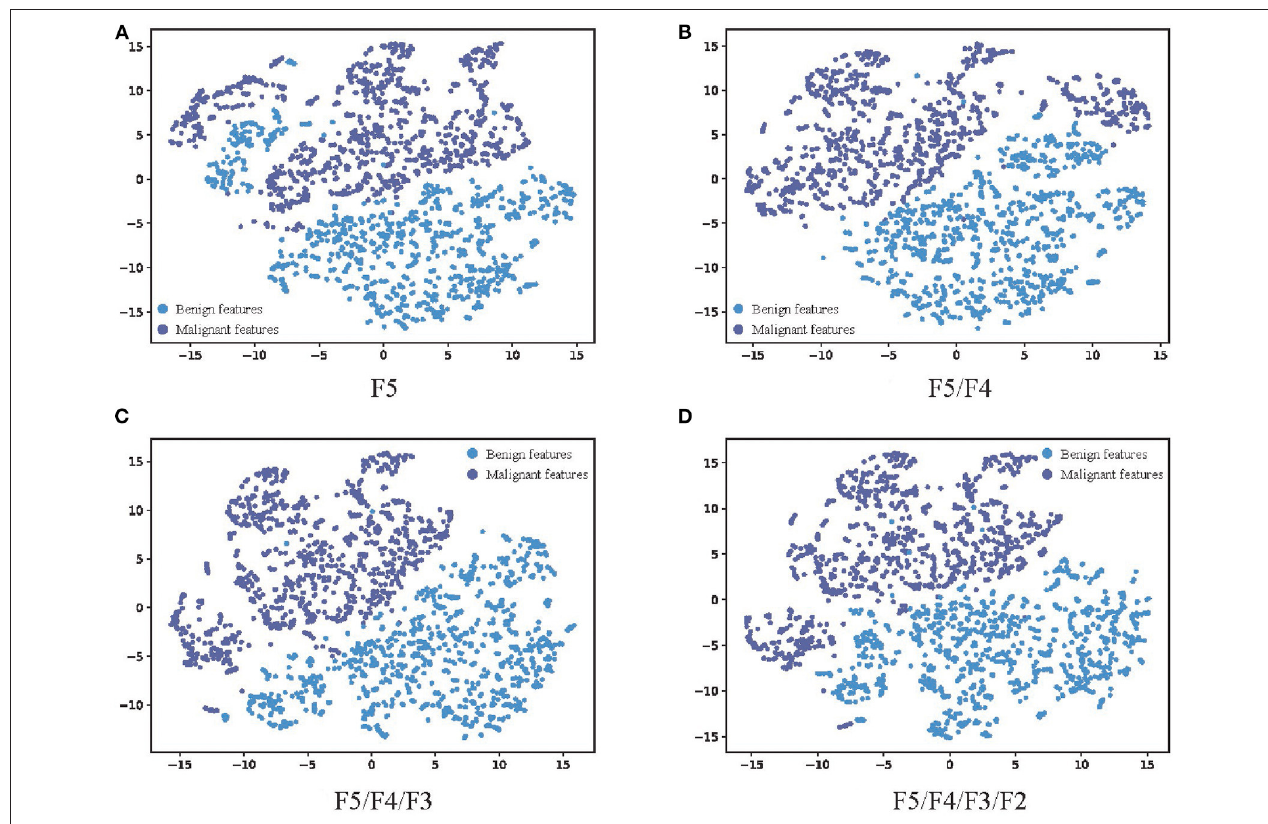
FIGURE 6 | The visualization results of the features extracted by networks with different numbers of feature fusion branch paths. (A) F5, (B) F5/F4, (C) F5/F4/F3, and (D) F5/F4/F3/F2. The feature vector in the second-to-last layer of the full connection layers are transferred from 1,024 dimensions to 2 dimensions through t-SNE. The blue scatter plots represent malignant features, and the purple scatter plots represent malignant features. The higher the linear separability of benign features and malignant features after dimensionality reduction, the more beneficial the features extracted from the network are for